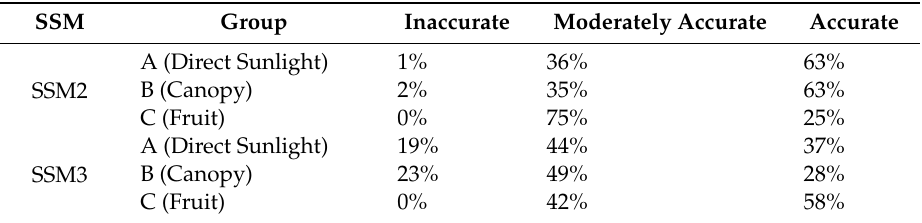
Table 9. Segmentation quality of spot separation method (SSM)2 /